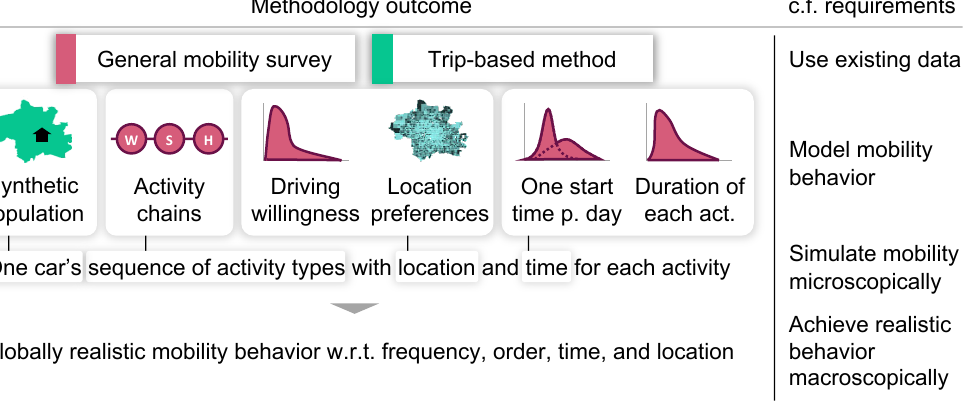
Figure 4. Definition of an activity-based mobility plan and outcomes of the methodology’s steps. Red and green elements belong to general and geospatial-specific mobility,